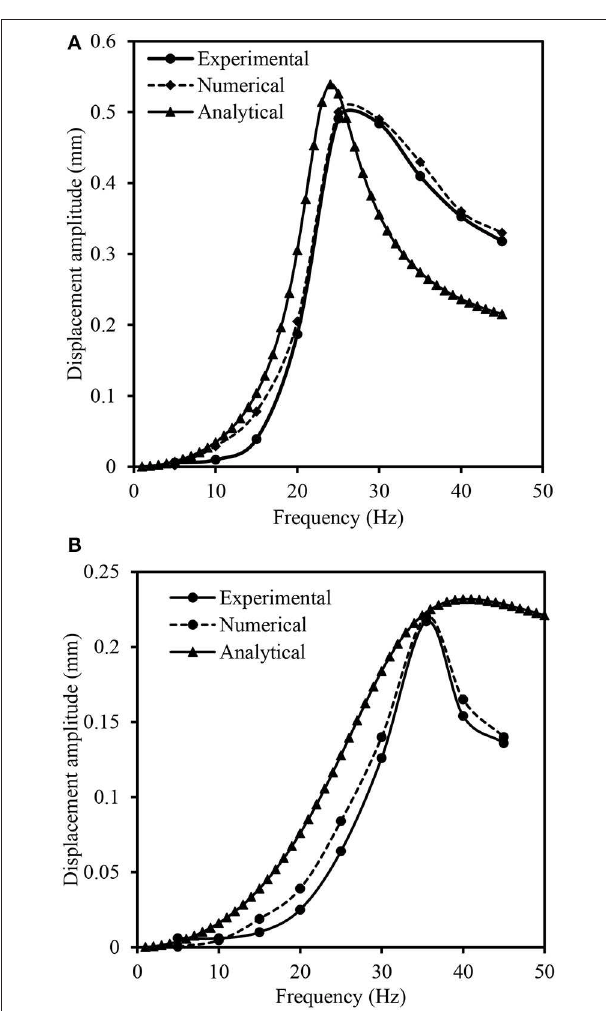
FIGURE 9 | Comparison of the results: (A) unreinforced; and (B) geocell reinforced subgrade sections.